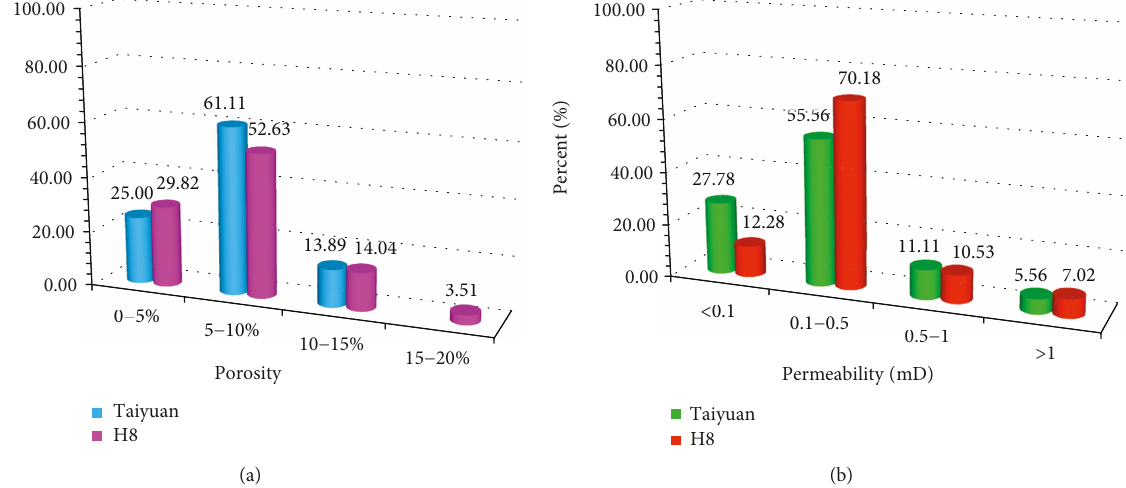
Figure 2: The distribution of porosity (a) and permeability (b) of samples.